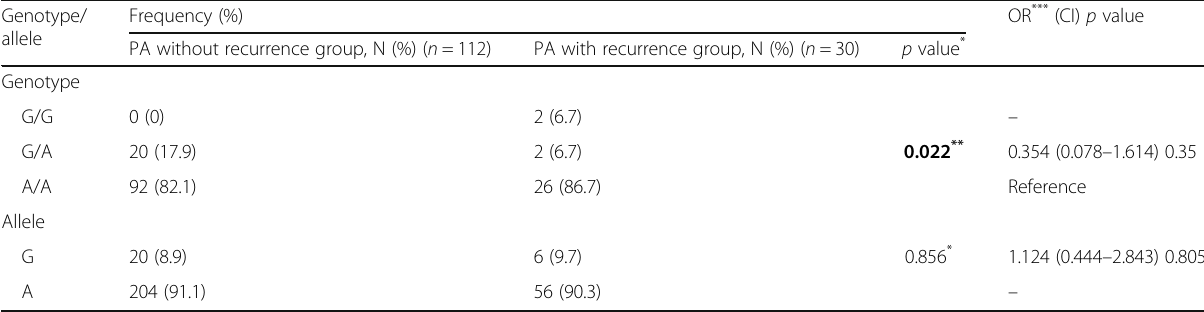
Table 3 The frequency of genotypes and alleles of rs3740051 in patients with PA without recurrence and PA with recurrence Genotype/ Frequency (%) OR *** (CI) p value allele PA without recurrence group, N (%) ( n = 112) PA with recurrence group, N (%) ( n = 30) p value *